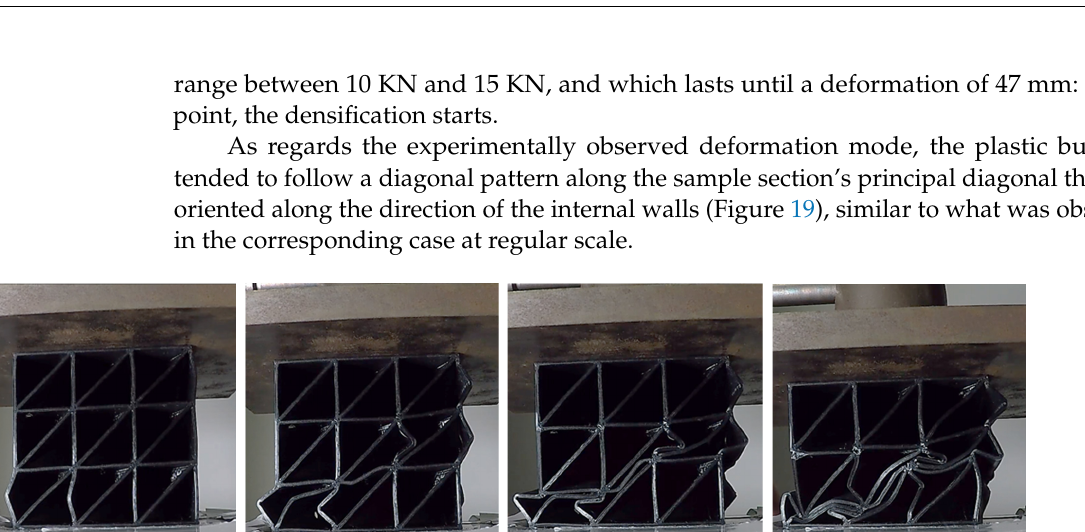
Figure 20. Experimental force ‐ displacement curves of the large ‐ scale specimens constituted by the hexagonal cell geometry and undergoing lateral load.